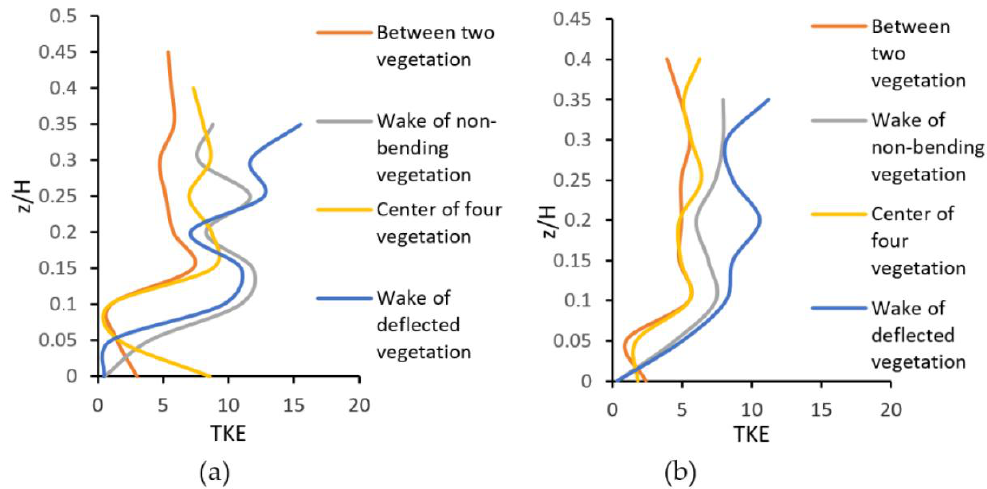
Figure 12. Comparison of Turbulence Kinetic Energy (TKE) between deflected vegetation morphol- ogy and non-bending vegetation morphology at different positions: ( a ) higher vegetation density (a = 0.624 m − 1 ); ( b ) lower vegetation density (a = 0.256 m − 1